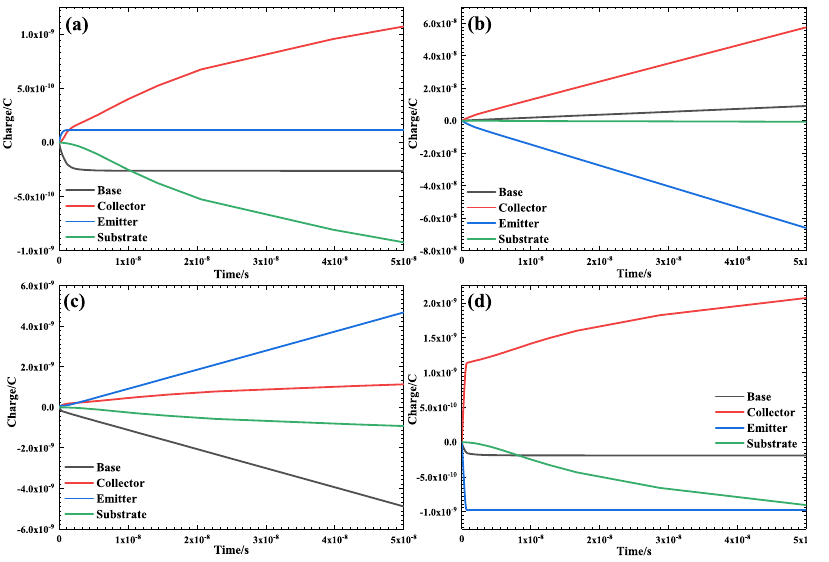
Figure 15. Change in collected charge with time when heavy ions vertically irradiate the emitter of the SiGe HBT under the substrate inverse bias ( a ), positive bias ( b ), off bias ( c ) and collector positive bias ( d )